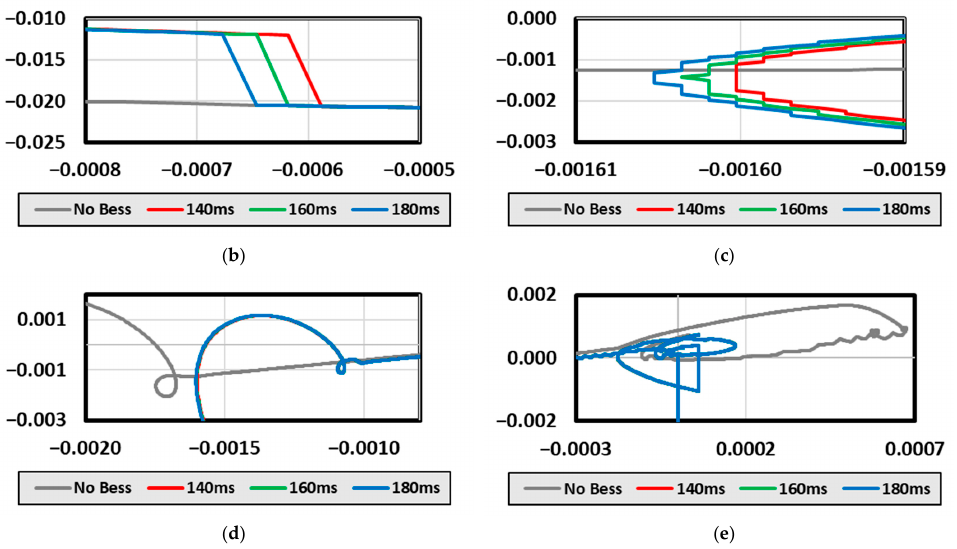
Figure 10. Curve about deviation of power and frequency by case study; ( a ) Power grid constant at entire period; ( b ) BESS response point; ( c ) Nadir frequency point; ( d ) Quasi − steady state point; ( e ) Overshooting point.